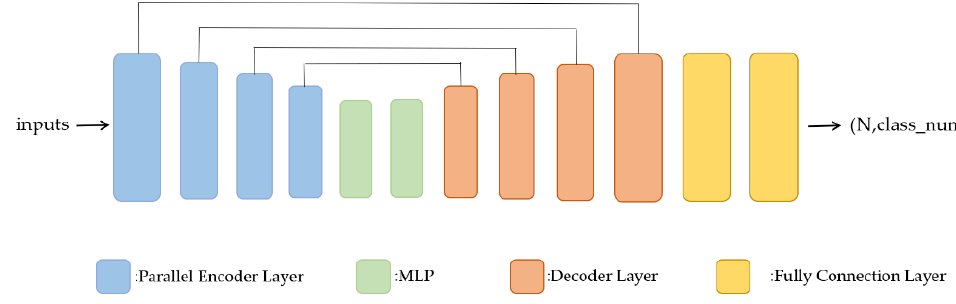
Figure 1. The proposed network architecture.